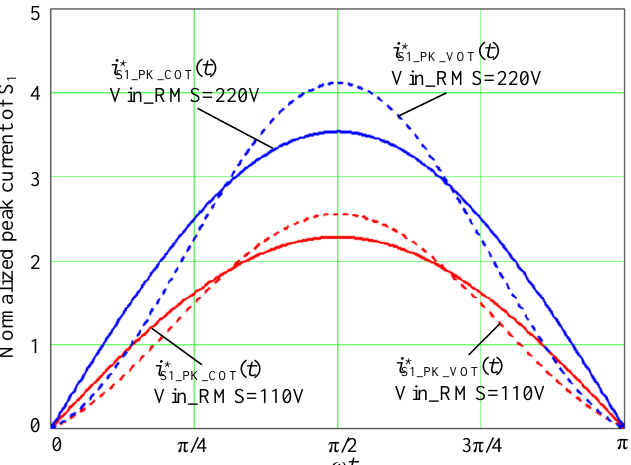
Figure 11. Comparison of the normalized peak current curves of S 1 with COT and VOT control during half line cycle .